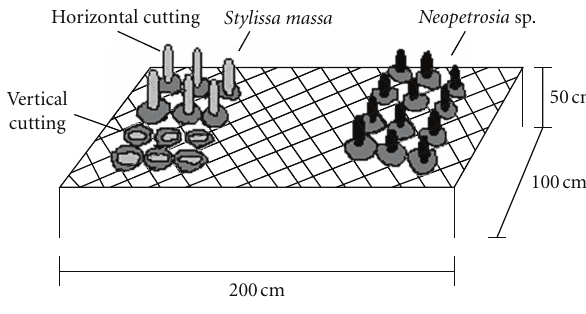
Figure 5: A scheme of Neopetrosia sp . (right) and S. massa (left) fragments on artificial substrate, placed on a metal grid at the field site Teluk